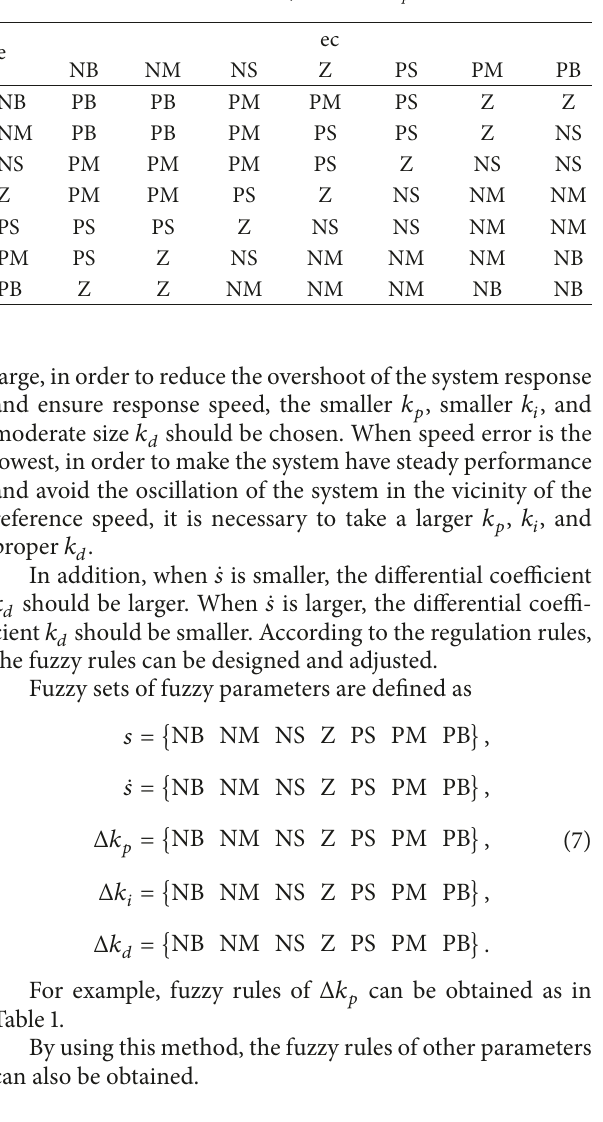
Table 1: Fuzzy rules of Δ𝑘 𝑝